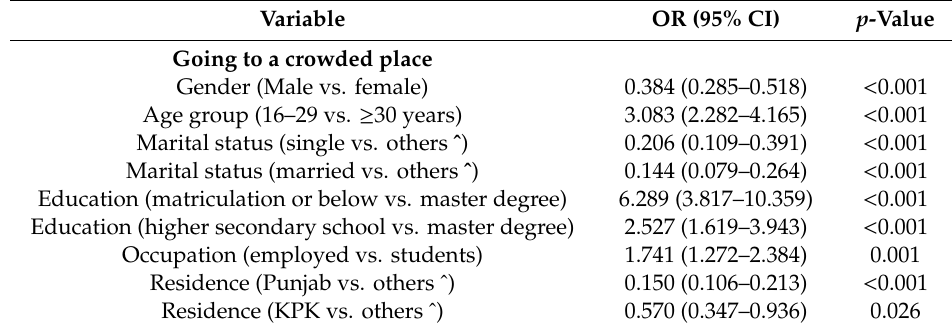
Table 6. Predictors of poor practices (going to a crowded place) towards